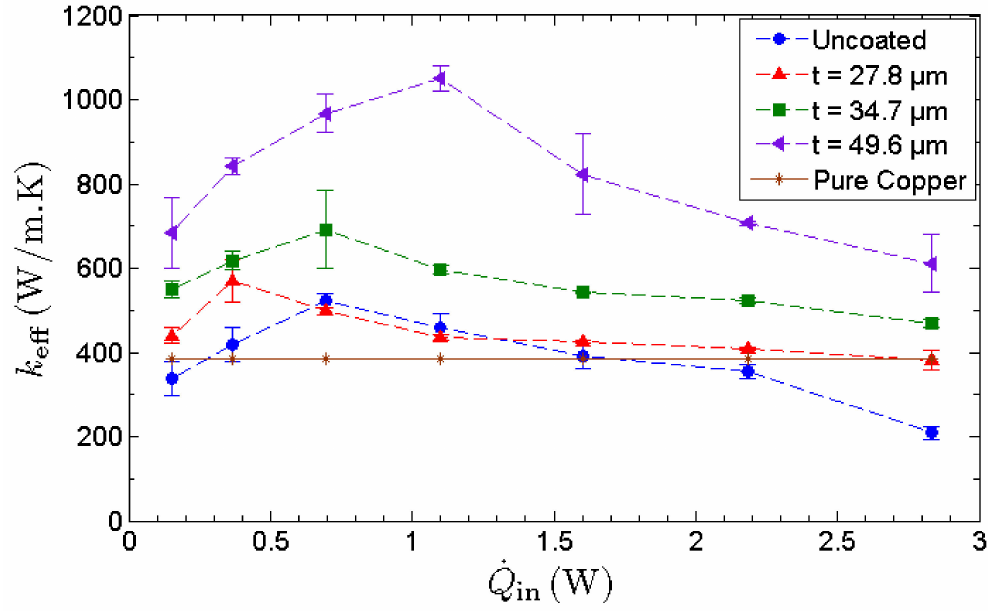
Figure 9. Effective thermal conductance, k eff , of MHPs as a function of heat input. The thermal conductivity of copper is used as a